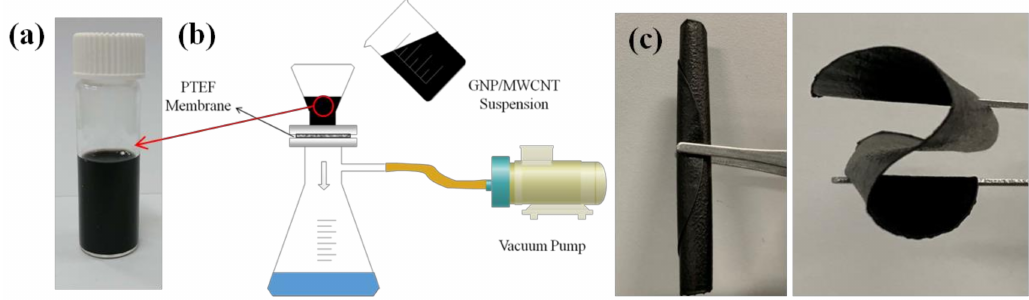
Figure 2. ( a ) MWCNT/GNP hybrid suspension, ( b ) schematic diagram of vacuum filtration, and ( c ) a flexible GNP/MWCNT hybrid film.